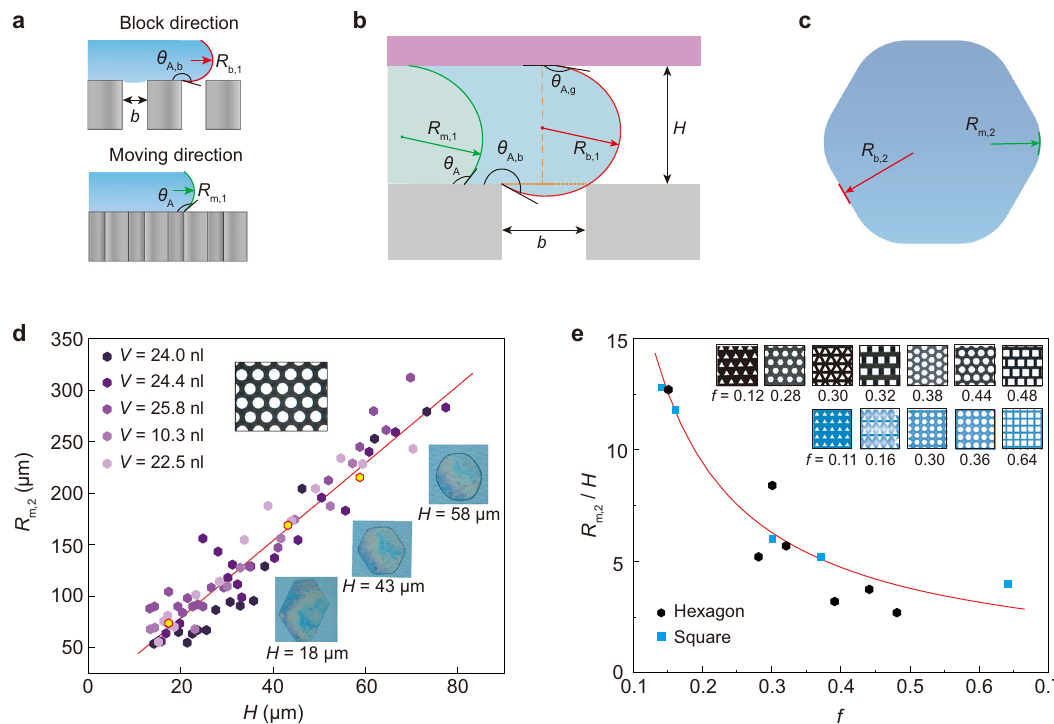
Fig. 3 Liquid pro fi le, geometrical parameters and evolution of the liquid fi lm. a Schematic illustration of the block (red arrow) and moving (green arrow) directions of the liquid pro fi le from the side view. R b,1 and R m,1 denote the curvature radii of the red and green curves, respectively. b Close-up showing the liquid pro fi le with relevant geometrical parameters. b denotes the spacing of the pillar, and H the separation between the upper glass plate and the pillar. θ A and θ A,b denote the advancing contact angles along the moving and block directions, respectively. θ A,g denotes the advancing contact of the glass plate. c Schematic illustration of the principal curvature radii R b,2 and R m,2 of the liquid-vapour menisci from the top view. d Evolution of the hexagonal droplet pattern with H and R m,2 . The dots are experimental data with different volumes, and the red line is obtained using the best fi t ( R m,2 / H ≈ 3.7). Insets showing the appearances of the surface and the representative liquid patterns (corresponding to the yellow dots). e The variations of R m,2 / H as a function of f for various cross-sections of the pillars and arrangements of the arrays (see insets), as well as the droplet shape. The dots are experimental data and the red curve represents the theoretical results obtained by Eq. (3). Source data are provided as a Source Data fi